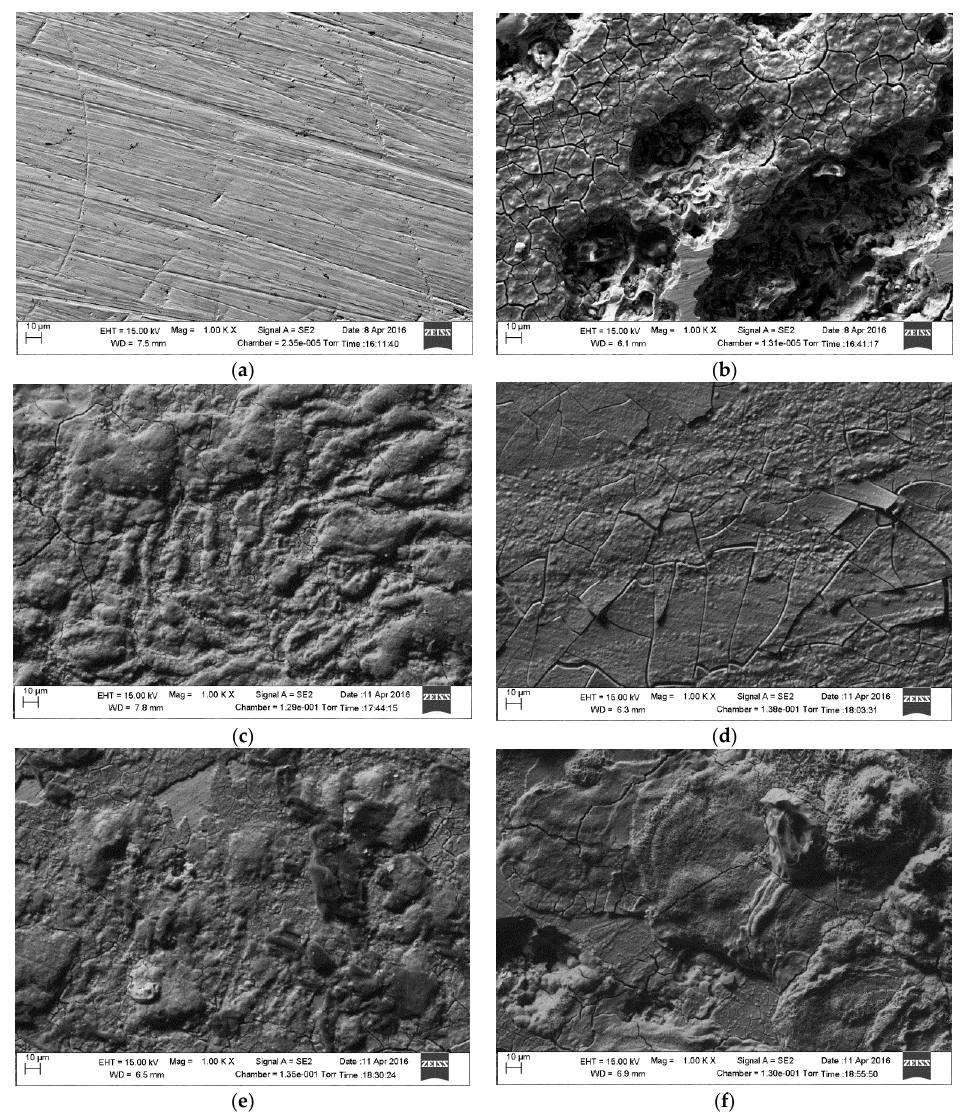
Figure 8. Scanning electron micrographs of mild steel surface before and after corrosion testing: ( a ) before immersion; ( b ) without inhibitor; ( c ) 1 g/L NO 2 − ; ( d ) 1 g/L NO 2 − + 0.5 g/L KI; ( e ) 1 g/L NO 2 − + 1 g/L KI; ( f ) 1 g/L NO 2 − + 2 g/L KI.